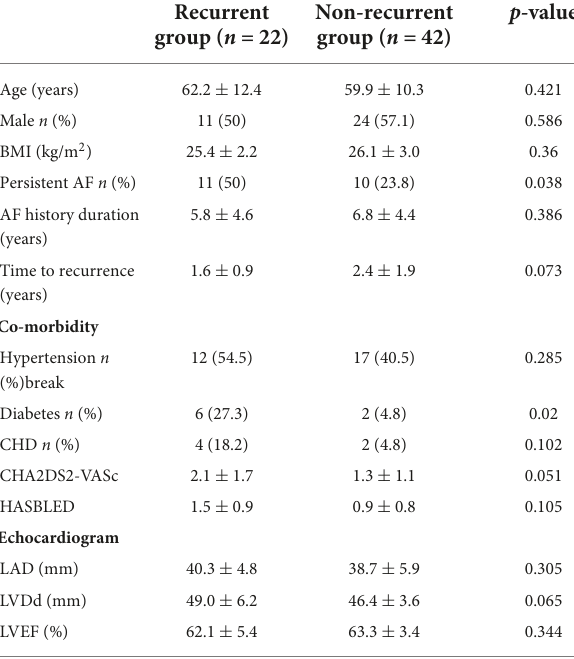
TABLE 1 Demographic and clinical characteristics of the recurrent and non-recurrent groups. Recurrent group ( n =